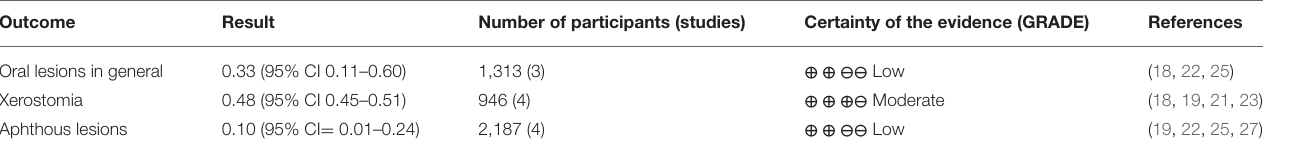
TABLE 4 | Grades of evidence (GRADE